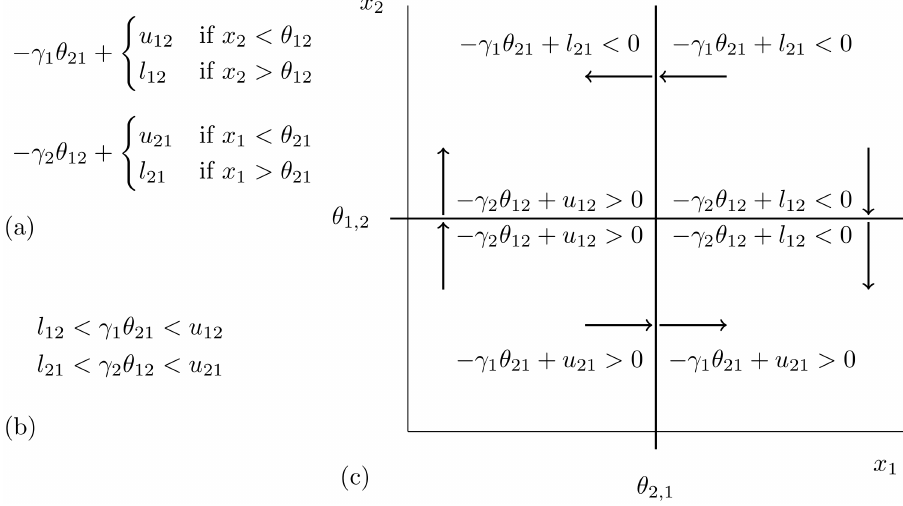
Fig 6. (a) Field equations for toggle switch. (b) Parameter values that are associated with parameter node 5 . (c) Evaluation of field inequalities at four 1-dimensional faces (walls) of domains based on the given parameter value. Arrows indicate direction of dynamics induced by